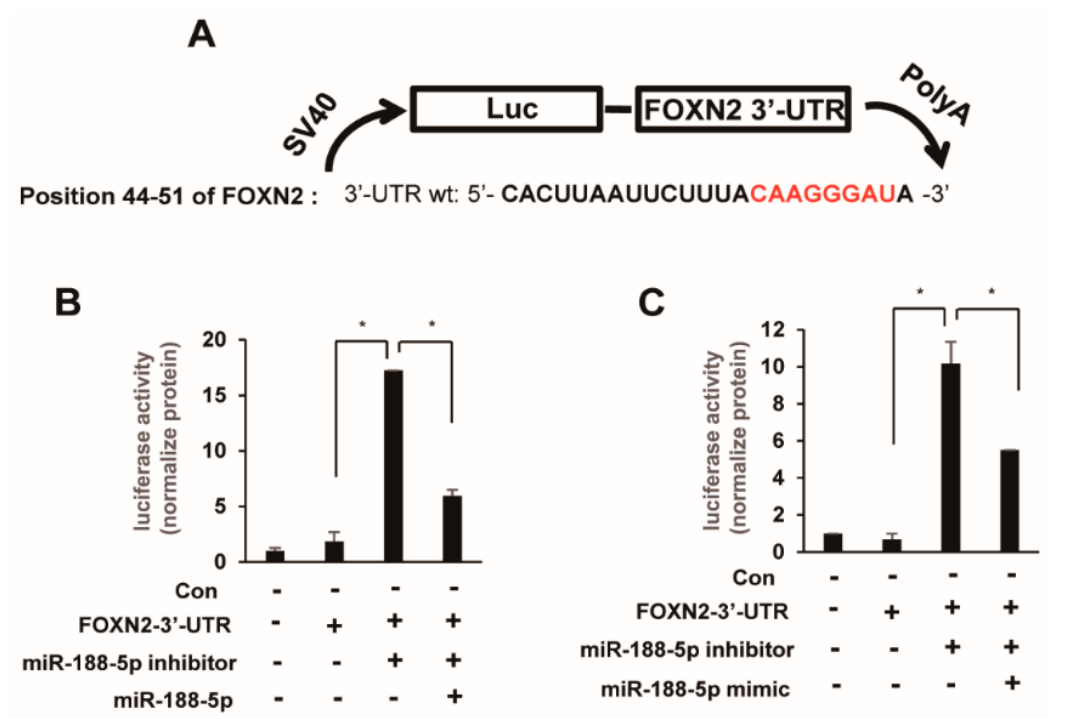
Figure 5. miR-188 downregulates FOXN2 expression by targeting the 3 ′ UTR of FOXN2 . ( A ) Schematic of predicted miR- 188 binding sites in the FOXN2-3 ′ UTR. The putative binding site of FOXN2 is the red color sequence. ( B ) Luciferase activity of reporters expressing the wild-type 3 ′ -UTRs of FOXN2 in FaDu cells cotransfected with the miR-188-5p inhibitor and pSuper/miR-188-5p or miR-188-5p mimic as indicated. Luciferase activity was assessed 24 h after transfection. ( C ) Lucif- erase activity of reporters with the 3 ′ -UTR of FOXN2 in HEK293 cells cotransfected with the miR-188-5p inhibitor or miR- 188-5p mimic oligonucleotides. The data are shown as the mean ± SD of at least three independent experiments. * p <